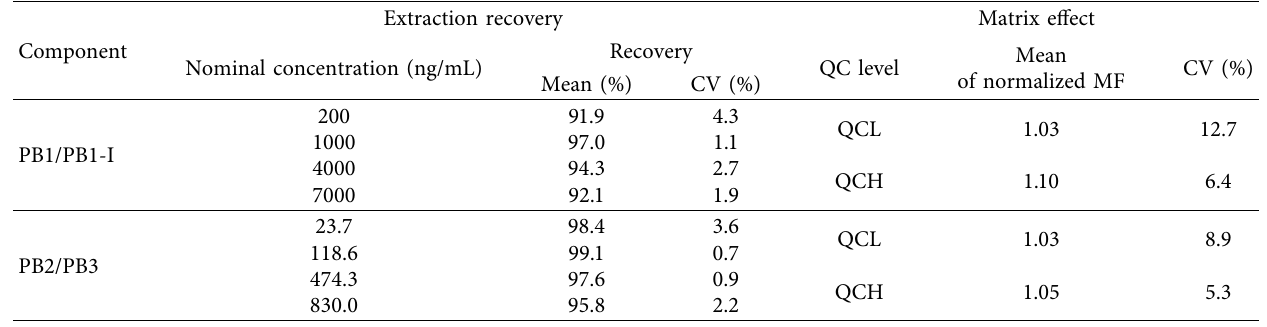
Table 1: Extraction recovery and matrix efect of PB.